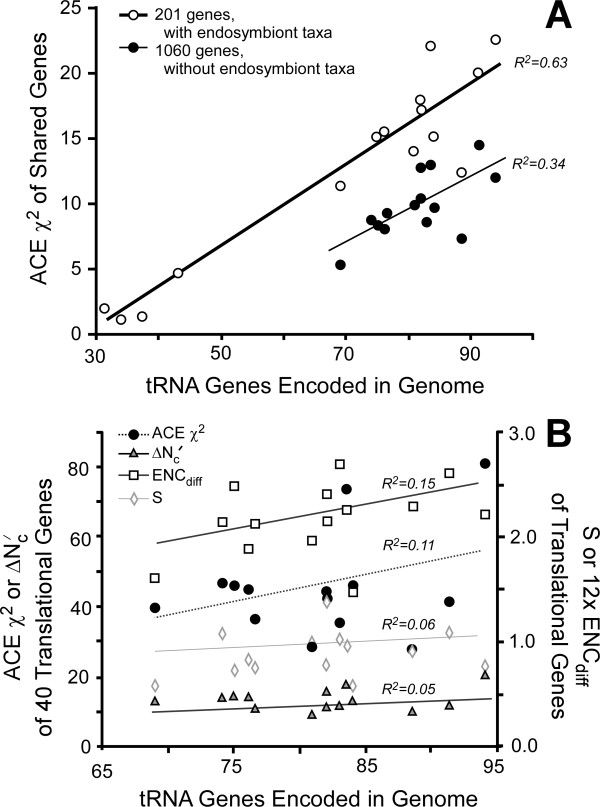
Codon selection as a function of tRNA gene number in Enterobacteriaceae. All codon statistics were calculated using the Translation40 gene set to construct fo and the shared set of ORFs to construct fn. A. ACEχ2 calculated on all shared genes, for the set of 14 free-living bacteria (1060 genes; open circles, thick line) and a set of 4 endosymbionts along with 11 free-living bacteria (201 genes; filled circles, thin line). B. ACEχ2, like other statistics, calculated on Translation40 gene set.